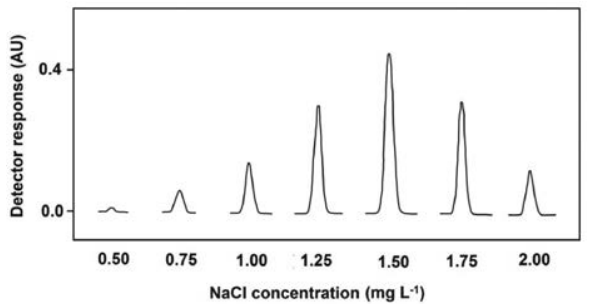
Figure 2. Effect of NaCl concentration on extraction efficiency. Ex- perimental conditions: 2 mL model urine sample containing estra-